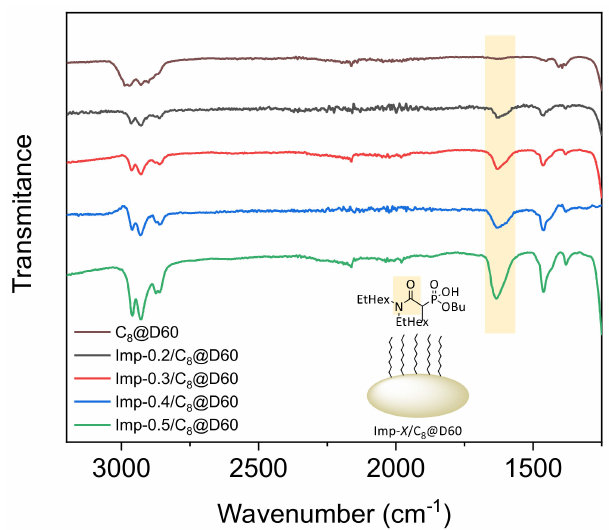
Figure 1. Fourier-transform infrared spectra of the pre-functionalized support (C 8 @D60) and the impregnated materials with different DEHCEBP loadings (0.2 − 0.5 mmol · g − 1